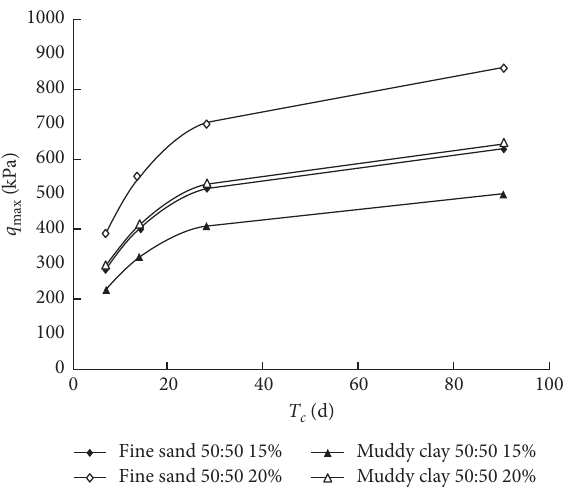
Figure 4: Influence of curing time on compressive strength.